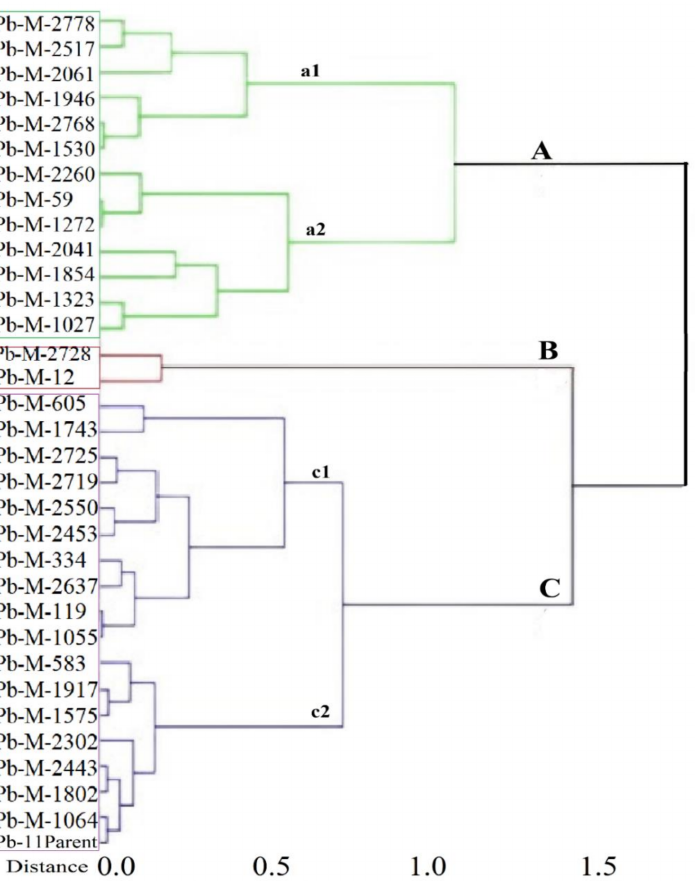
Figure 5. Cluster dendrogram of 32 mutant lines and the wild type based upon mean yield index values calculated for both generations (M 7 and M 8 ) and locations (NIBGE and